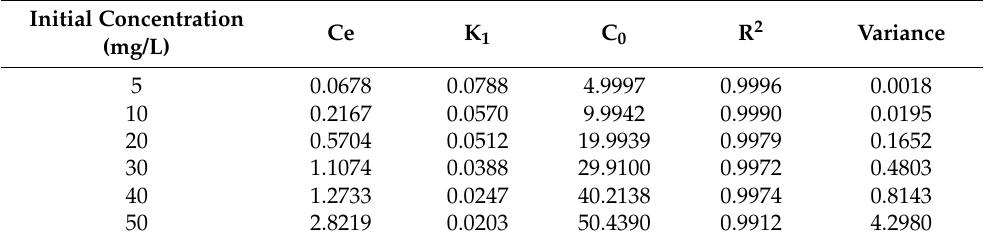
Table 5. The parameter values of the PFO models obtained by numerical calculation for the removal process by the W3 membrane with different initial concentrations.